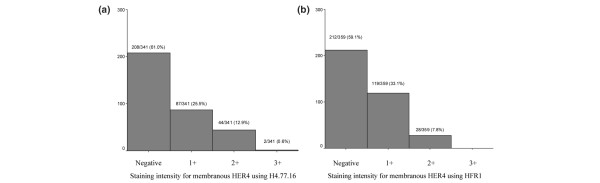
Frequency histograms for membrane staining intensity using (a) H4.77.16 and (b) HFR1.